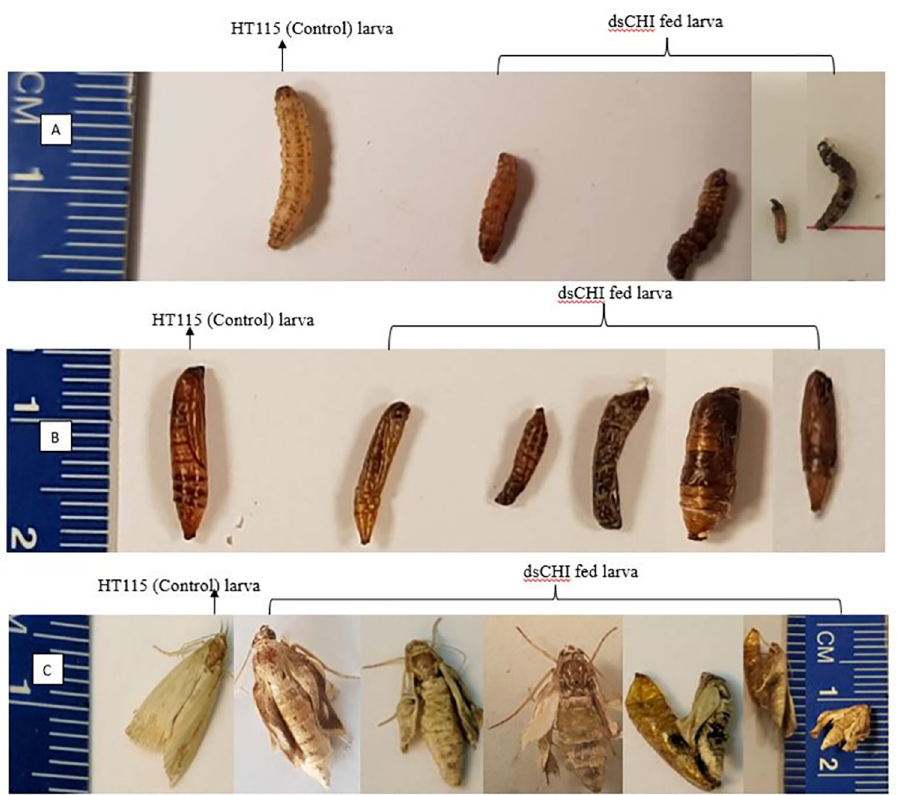
Fig 4. The effect of dsCHI on the various phenotype (A) various deformed shapes of dsRNA fed larvae compared to those feed without dsRNA (control), (B) different morphological deformity observed in some pupa from dsRNA fed larvae compared to the normal pupa (control), C) phenotype abnormality resulted from dsRNA fed larva compared to larvae that was fed with control.